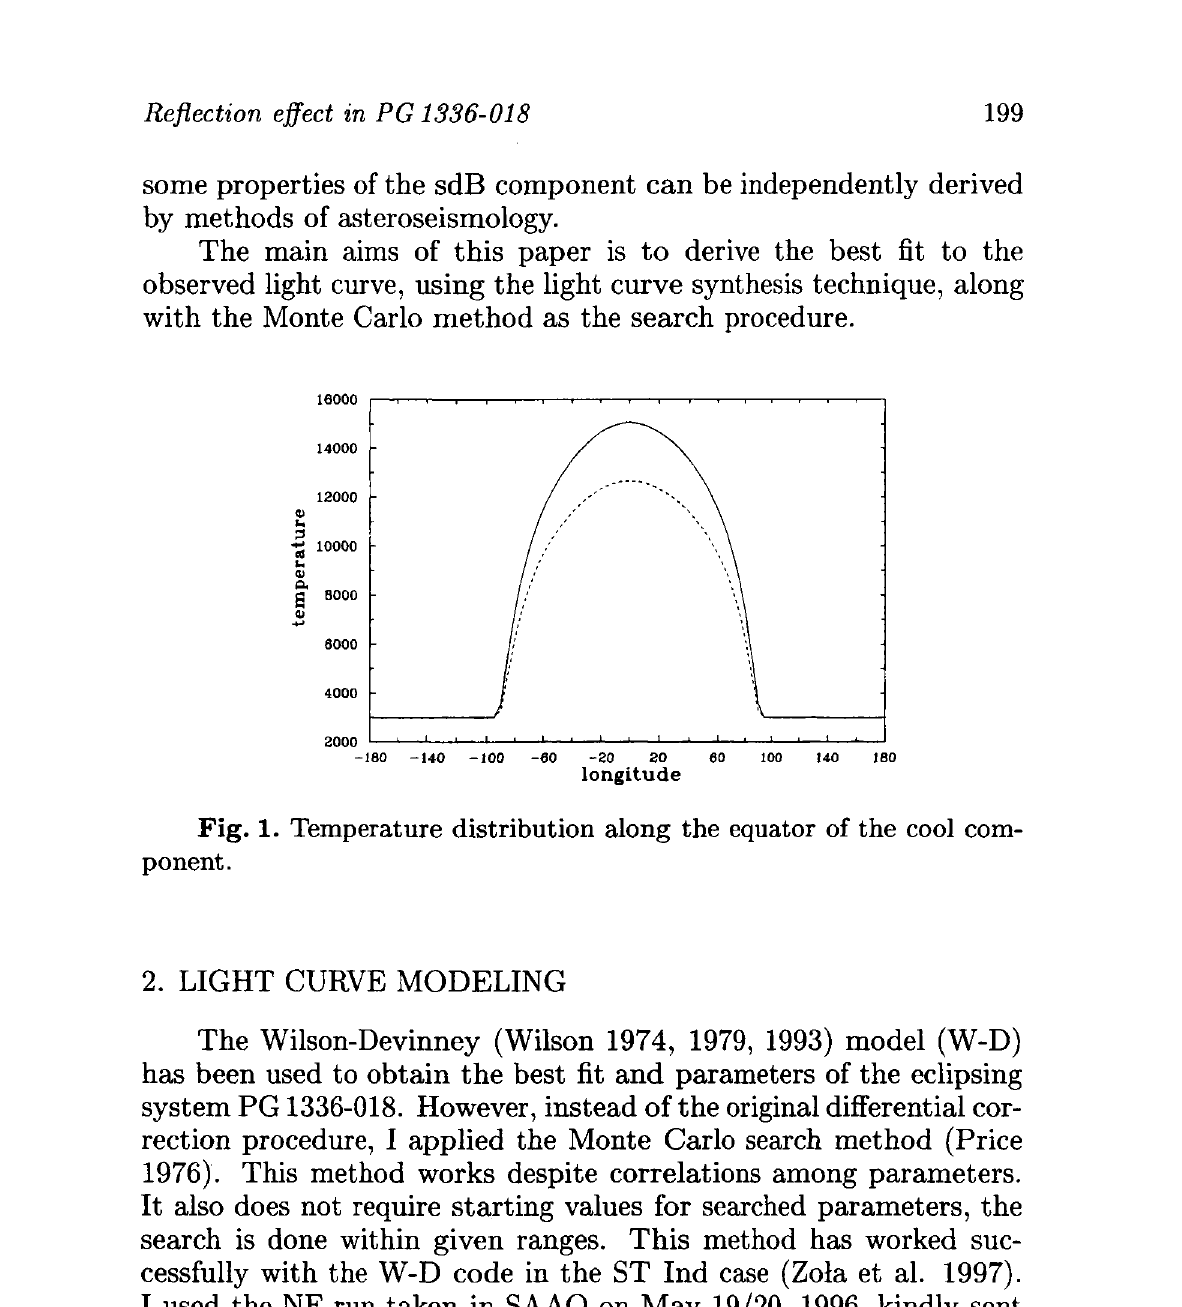
Fig. 1. Temperature distribution along the equator of the cool com-